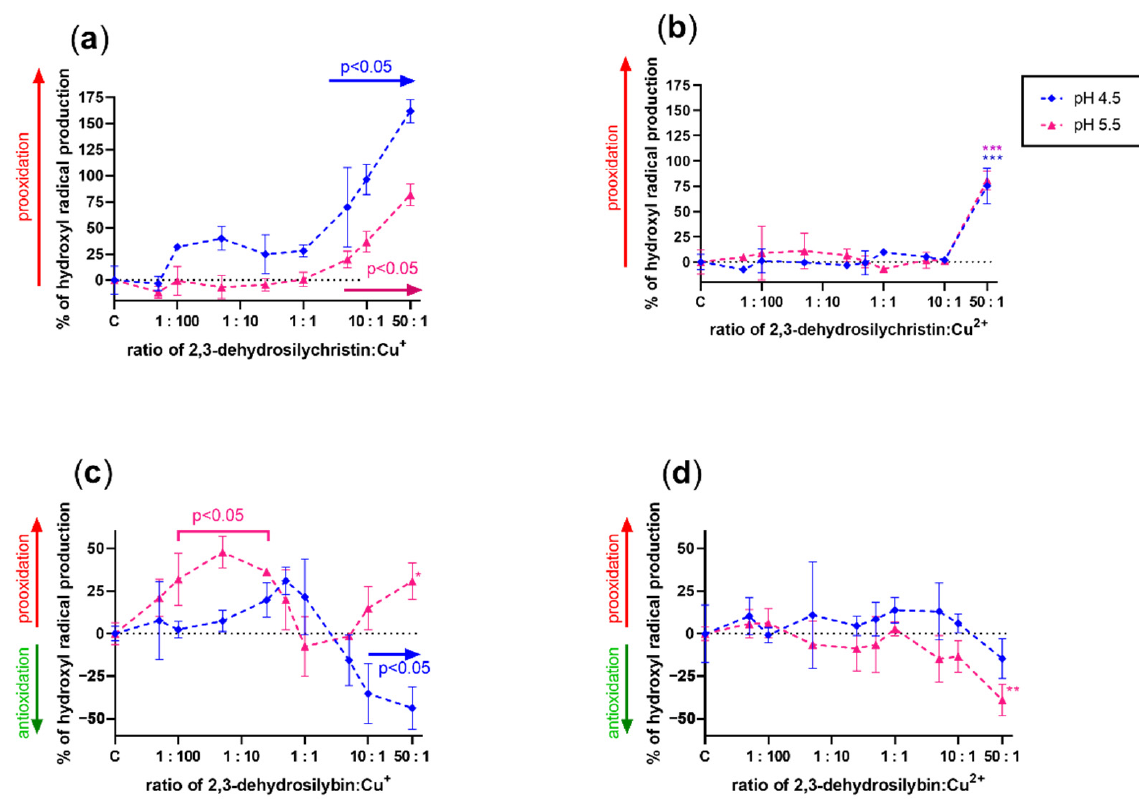
Figure 7. Effect of 2,3-dehydrosilychristin and 2,3-dehydrosilybin on the copper-based Fenton chemistry at pH 4.5 and 5.5: ( a ) 2,3-dehydrosilychristin + Cu + ; ( b ) 2,3-dehydrosilychristin + Cu 2+ ; ( c ) 2,3-dehydrosilybin + Cu + ; ( d ) 2,3-dehydrosilybin + Cu 2+ . Statistical significance vs. the control (C: positive blank—the Fenton reaction with the solvent alone) is shown directly in the figure or for isolated points as * p < 0.05, ** p < 0.01, or *** p <